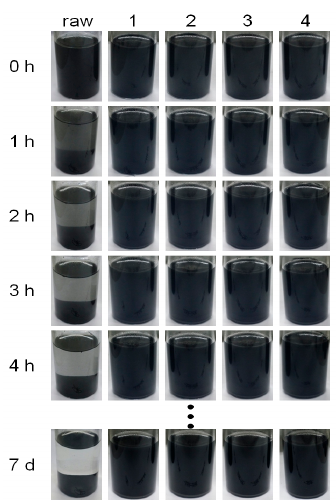
Figure 6. Photographic images for HOPG dispersions versus time obtained for pristine HOPG (M-25, raw ), HOPG with PTFEMA 66 - b -PVP 41 ( 1 ), PTFEMA 66 - b -PVP 205 ( 2 ), PTFEMA 136 - b -PVP 31 ( 3 ), and PTFEMA 136 - b -PVP 194 ( 4 ).